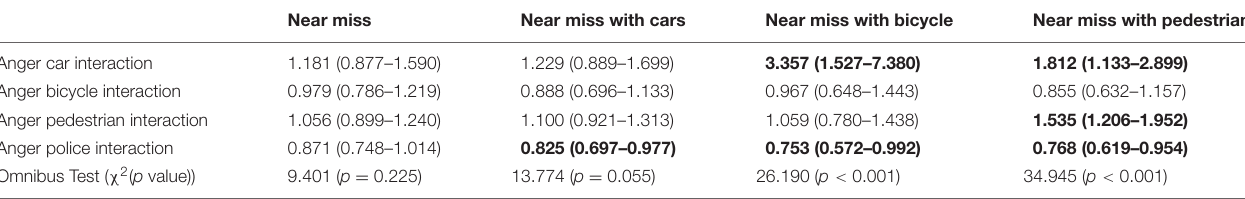
The values in the rows of the anger subscales correspond to the Exp( β ) (CI). Values bigger than 1, with CI not including it, represent an increase in probability due to increases of the independent variable and vice versa. Values in bold are statistically different than 1. The four subscales where included as predictors in the model